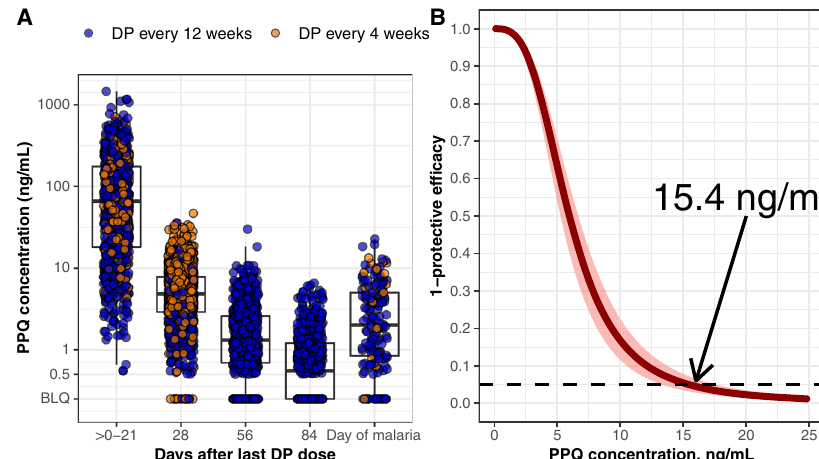
Fig. 5 Relationship between piperaquine (PPQ) concentration and protective ef fi cacy. A Measured PPQ concentrations by days after dihydroartemisinin-piperaquine (DP) and at time of malaria diagnosis ( n = 280 children). Points indicate observed data, boxes indicate PPQ levels for 25% (minima), 50% (center), and 75% (maxima) of the population, and vertical bars represent PPQ levels for 95% of the population. B Relationship between PPQ concentration and protective ef fi cacy. The solid line indicates the median estimate from the pharmacokinetic/pharmacodynamic model, and the shaded areas the 95% con fi dence interval. The indicated concentration (15.4 ng/mL) reduced the hazard of incident malaria by 95%.